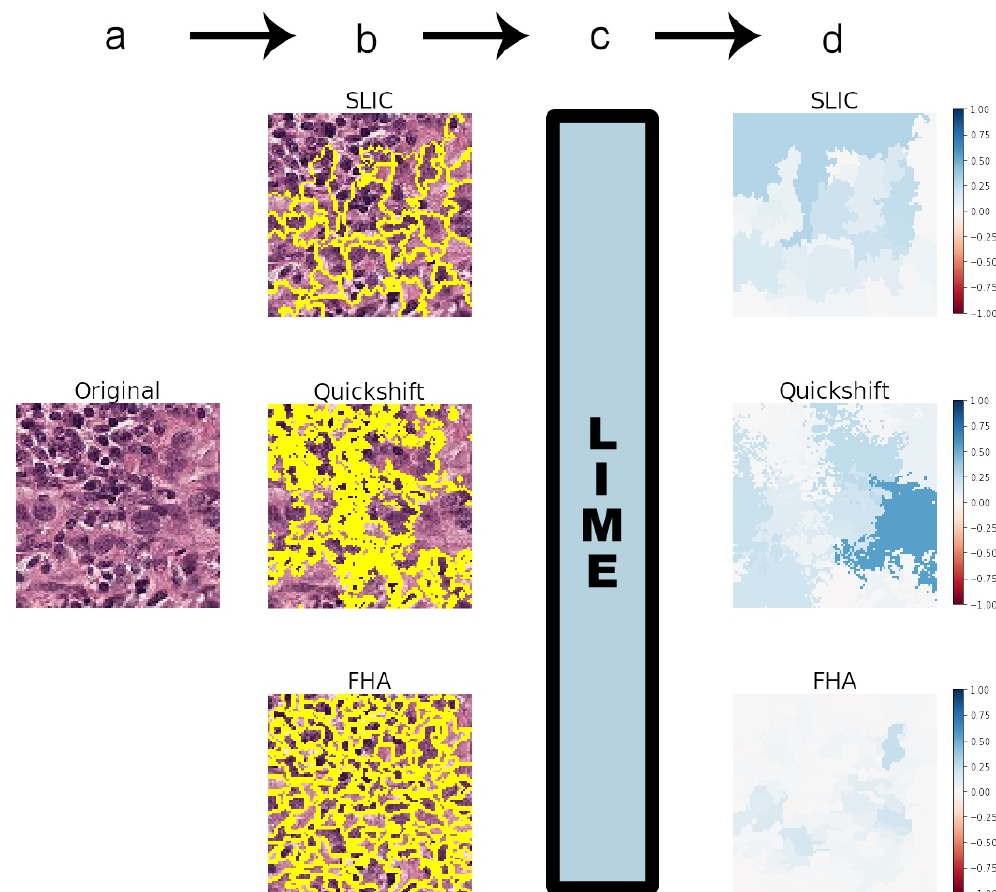
Figure 3. Methodology flowchart, showing the segmentation algorithms included in the LIME implementation: the Simple Linear Iterative Clustering (SLIC), quickshift, and Felzenszwalb (FHA) algorithms. Panel ( a ) shows the first step, where an image is taken to be classified by the chosen CNN model. In Step ( b ), this image is segmented into superpixels by any chosen segmentation algorithm. Step ( c ) comprises inputting the image and the defined superpixels into the LIME algorithm. Step ( d ) involves plotting the outputs of LIME as a heat map with a blue-red color map in the [ − 1, 1] range. This heat map was the generated explanation for the CNN classification of the image in Step (a). As seen in Panel (d), explanations were very dependent on the segmentation